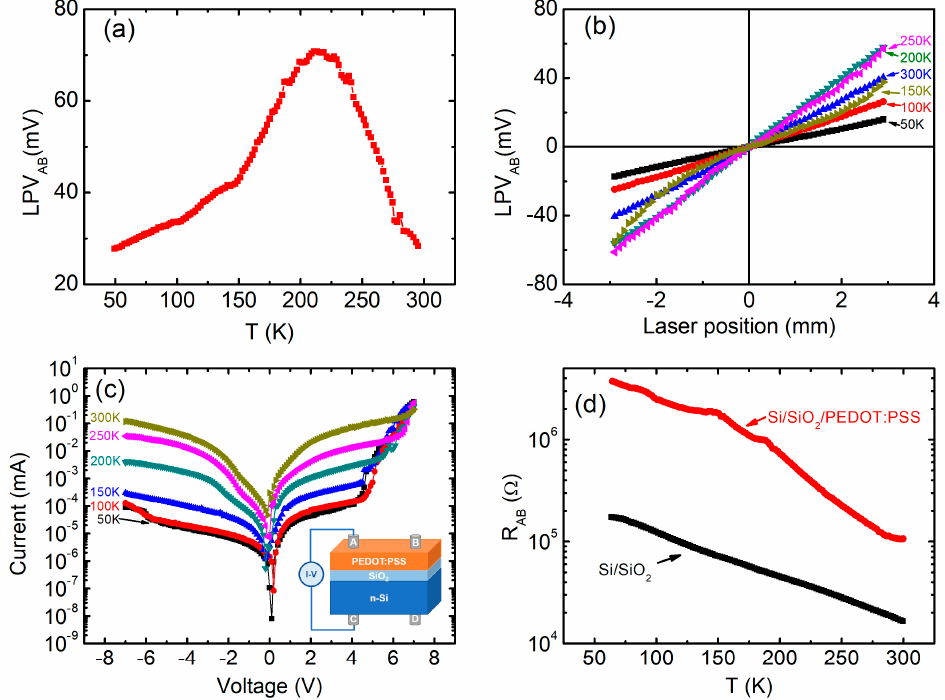
Figure 4. ( a ) Temperature dependence of LPV AB , ( b ) LPV AB curves and ( c ) I-V curves for Si/SiO 2 /PEDOT:PSS at different temperatures. ( d ) Temperature dependence of resistances (R AB ) of Si/SiO 2 /PEDOT:PSS and Si/SiO 2